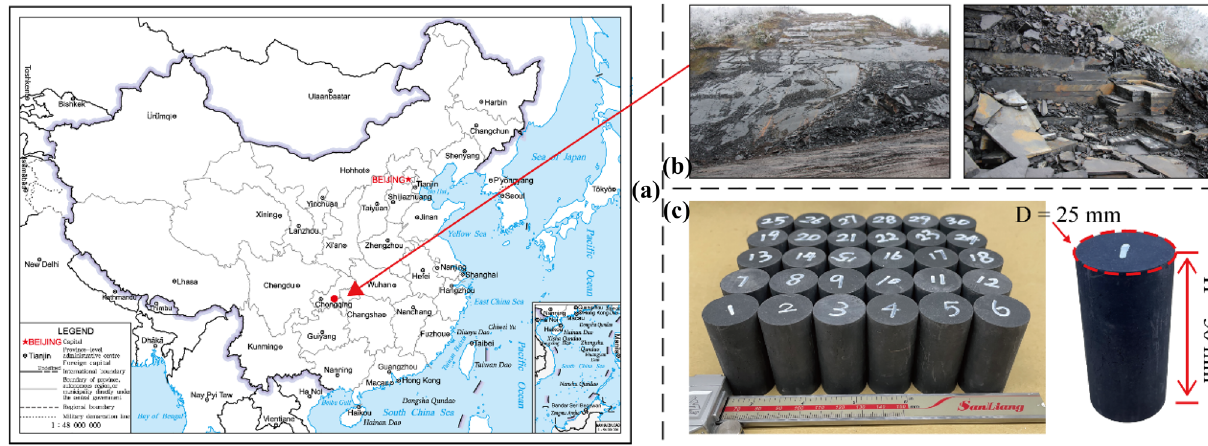
Fig. 2 Sampling Point, Shale landscape and sample